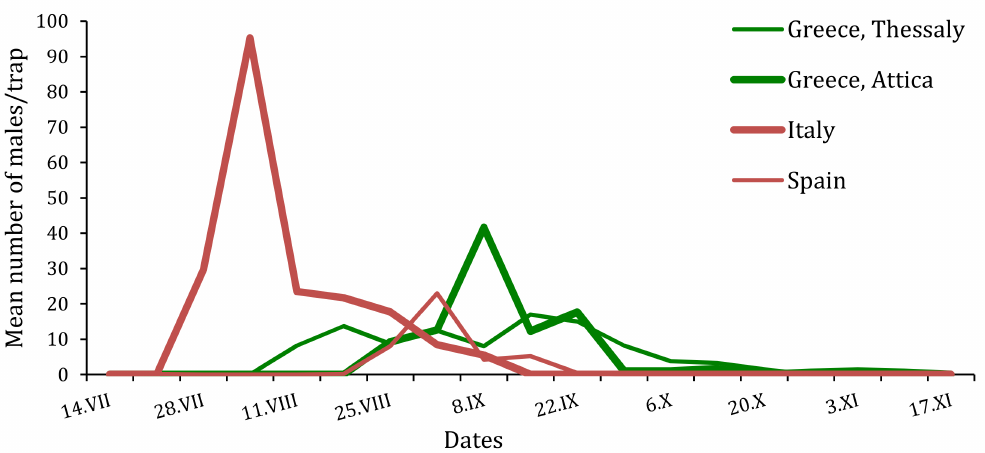
Figure 4. Flight phenologies of T. hellenica and T. pityocampa males trapped in the four experimental sites of Greece, Italy and Spain during the monitoring period